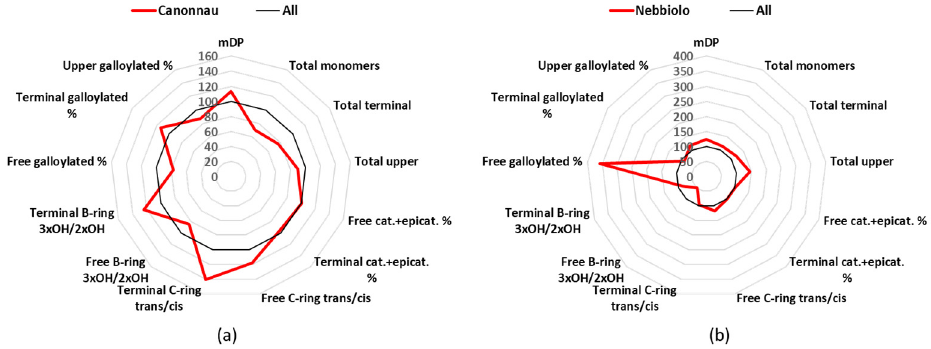
Figure 6. Radar graph comparing the percentage of the relative mean values of Cannonau ( a ) and Nebbiolo ( b ), with the mean values of the 12 groups considered as 100%. cat.: catechin, epicat: epicatechin.